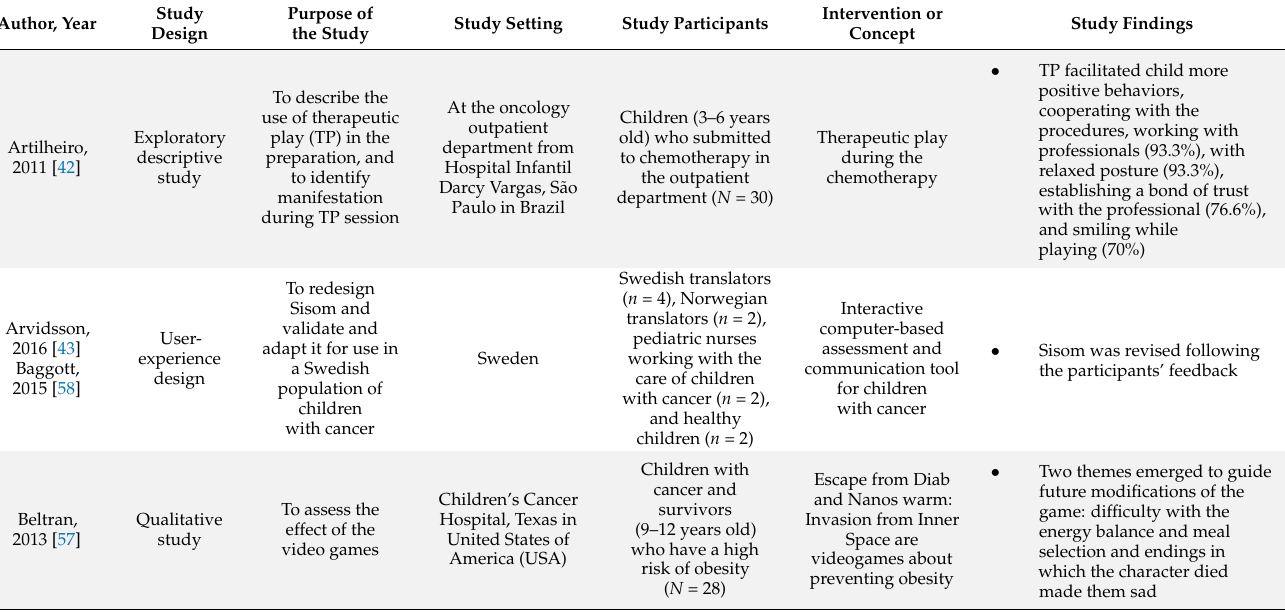
Table 1. Characteristics of included